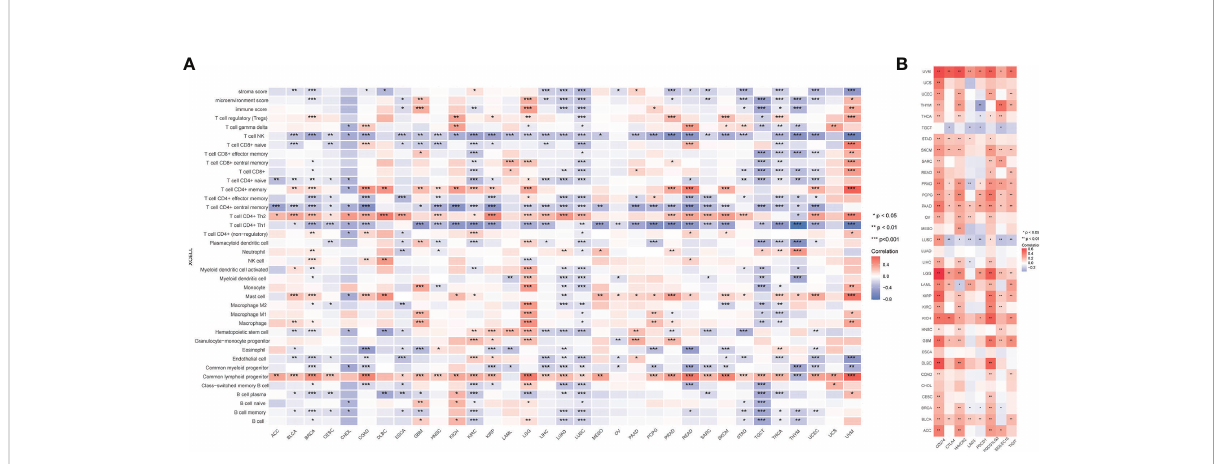
FIGURE 8 Systematic analysis of the links between GCLM expression and immune in fi ltration in pan-cancer. (A) XCELL analysis the links between GCLM expression and immune cells in pan-cancer. (B) Correlations of GCLM and immune checkpoints in pan-cancer. *p < 0.05; **p < 0.01, ***p <